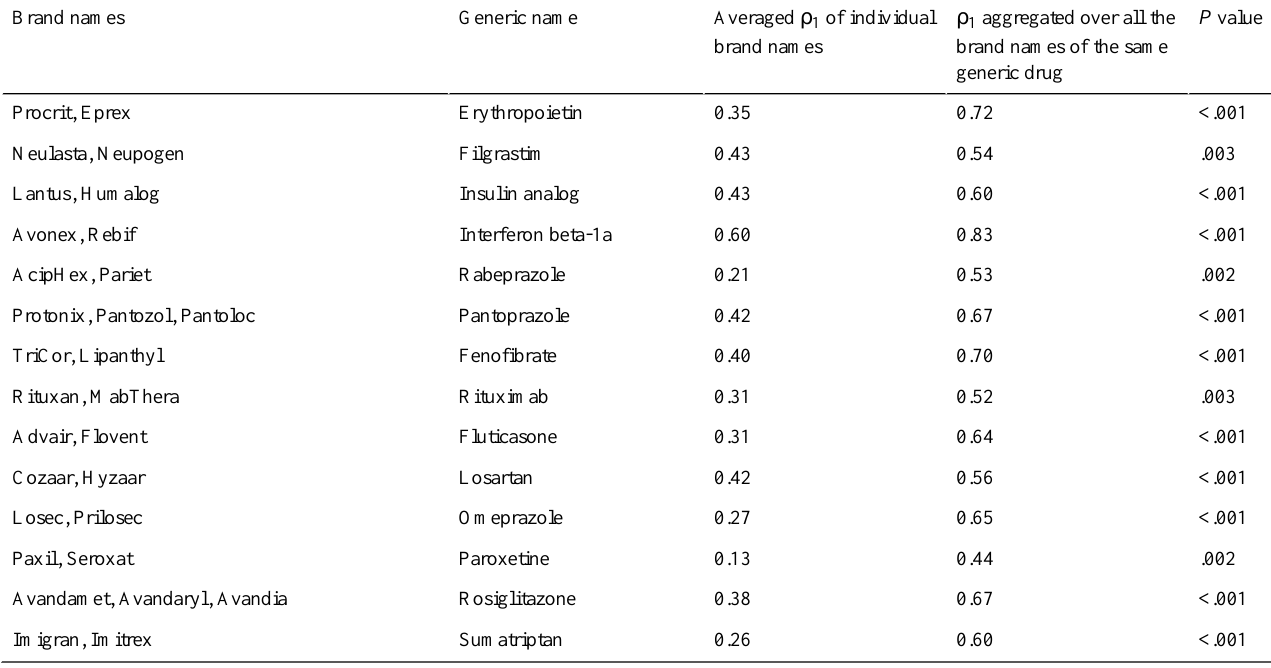
Table 5. Spearman rank correlation ( ρ ) between the adverse drug reports (ADRs) of generic drugs as identified by query log reaction score (QLRS) and by the number of reports in the Adverse Event Reporting System (AERS), with most discordant ADRs (MDADRs) removed according to the raw report counts in AERS. The QLRS and AERS counts for the generic drugs were computed by aggregating over multiple brand names of the same generic drug. For statistically significant correlations, P values are provided